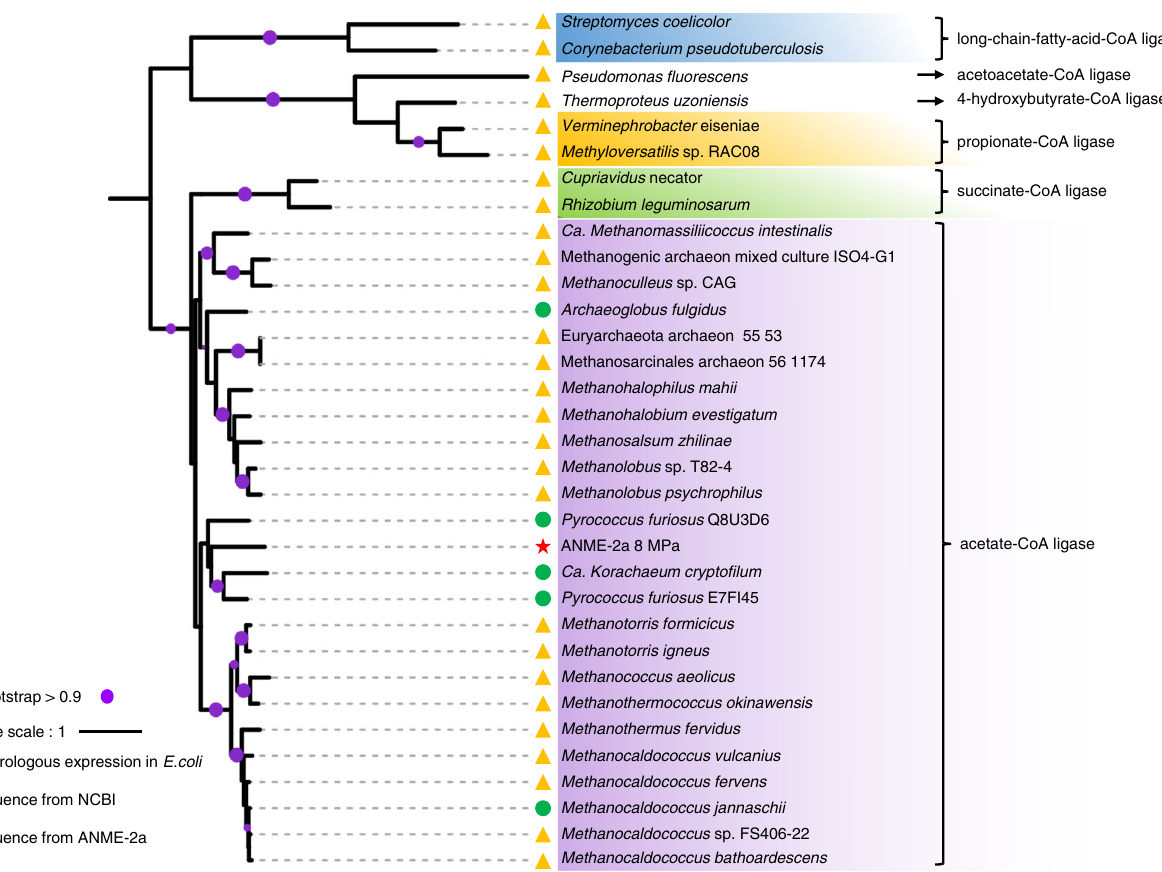
Fig. 3 Veri fi cation of the acd gene sequence from ANME-2a. Sequence from ANME-2a is marked as red asterisk, seqences from NCBI database that have been heterologous expressed in E.coli are marked as green dots, and other sequences from NCBI database are marked as yellow triangle. The purple dot indicates the clustering with bootstrap value above